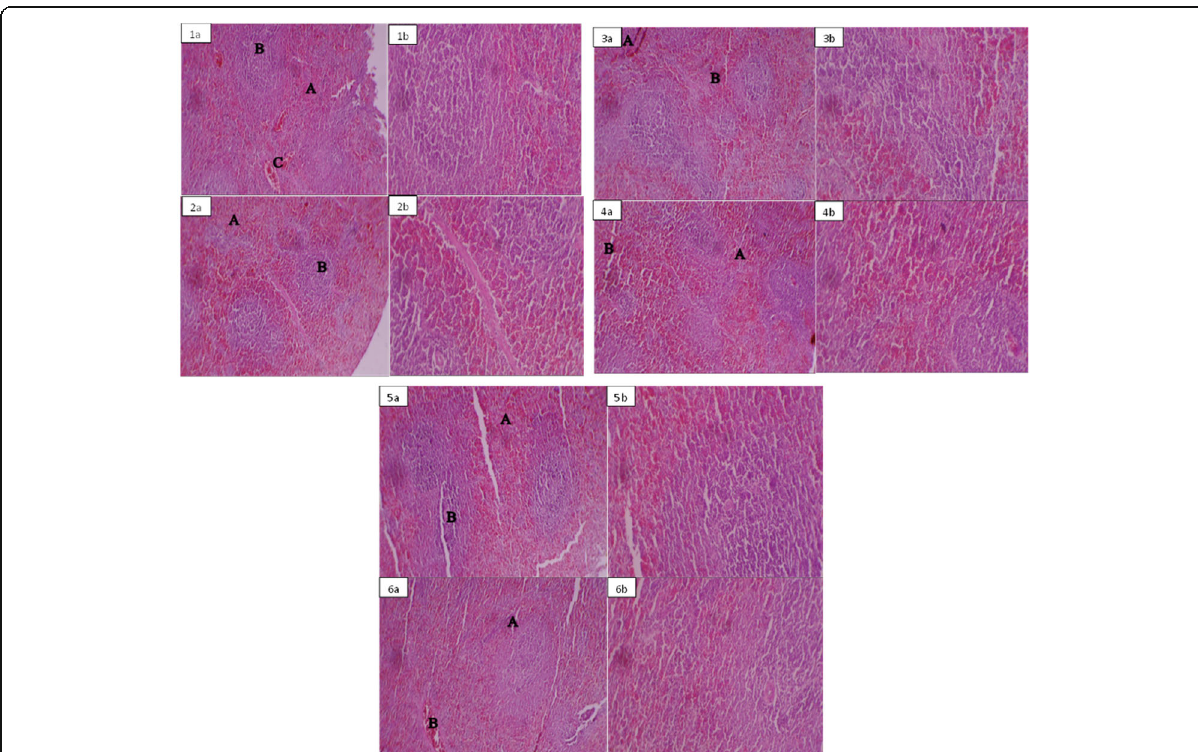
Fig. 1 Histological sections of the Spleen. Plate 1a (Control) - Spleen section showing A (red pulp), B (white pulp) and C (sinuses) [H&E × 40]. Plate 1b (Control) - Higher magnification of A and B [H&E × 100]. Plate 2a (Group F) – Spleen section showing A (moderate expansion of red pulp) and B (contraction of lymphoid follicles) [H&E × 40]. Plate 2b (Group F) Higher magnification of A and B [H&E × 100]. Plate 3a (Group B) Spleen section showing A (mild sinus histiocytosis) and B (red pulp expansion) [H&E × 40]. Plate 3b (Group B) Higher magnification of A and